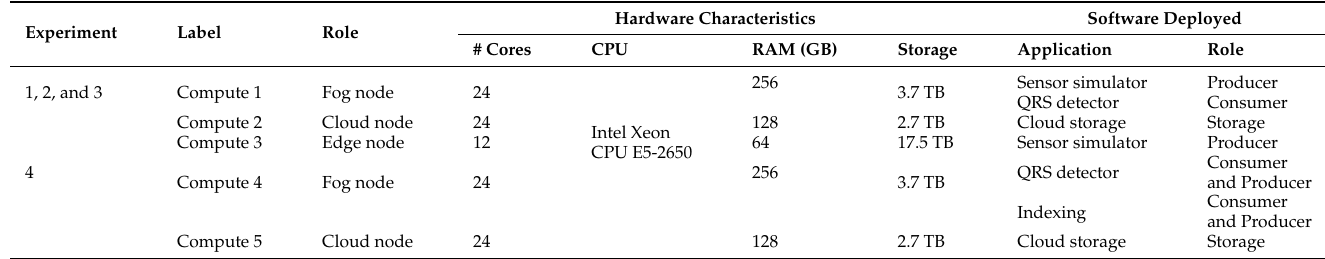
Table 2. Characteristics of the infrastructure used to conduct the experimental